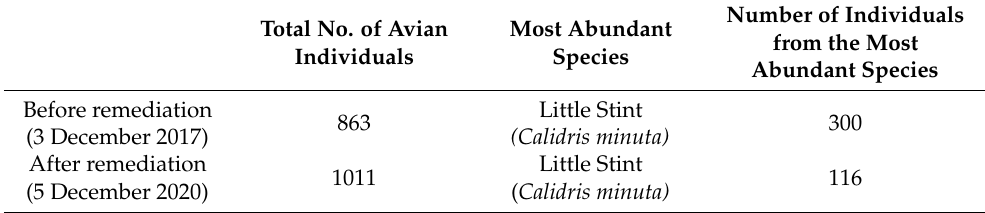
Table 3. Preliminary observation of arbitrary sampling in December 2017 and December 2020. Number of Individuals Total No. of Avian Most Abundant from the Most Individuals Species Abundant Species Before